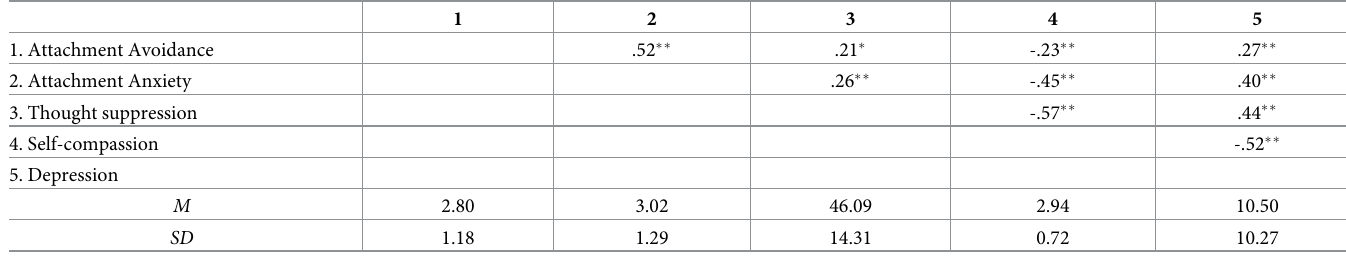
Table 1. Spearman’s correlations, means and standard deviations between key study variables (n = 148).